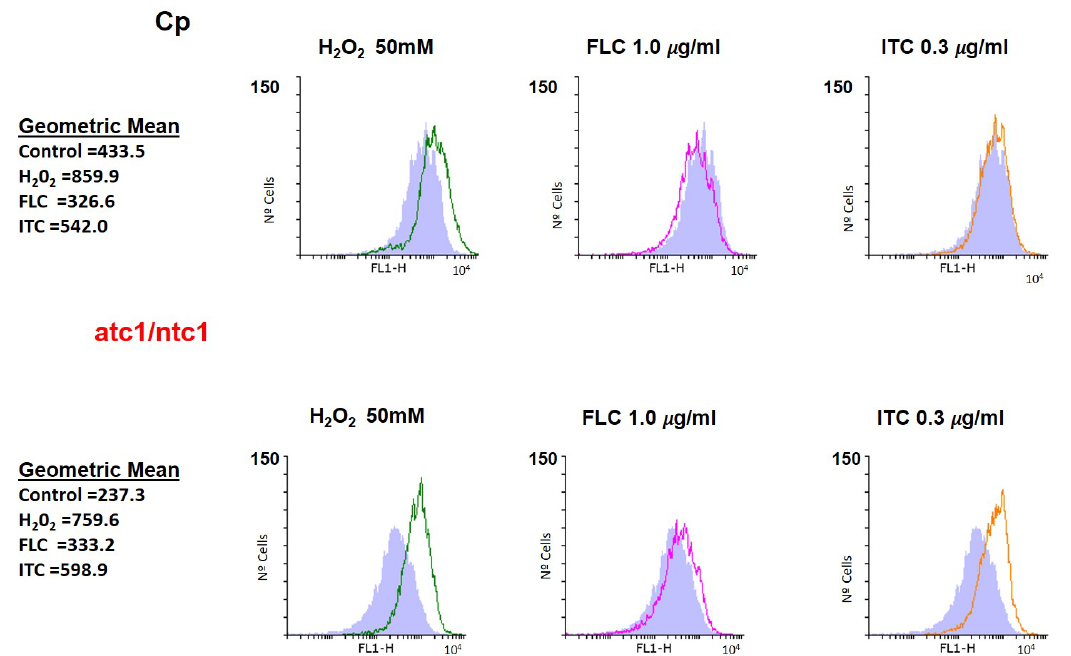
Figure 3. Determination of mitochondrial membrane potential after treatment with FLC and ITC. Equivalent cell samples harvested from actively growing cells were treated with the azoles for 1 h at 37 ◦ C and immediately analyzed by flow cytometry using Rhodamine 123 (20 µ M) as described in Methods. For other details, see Figure